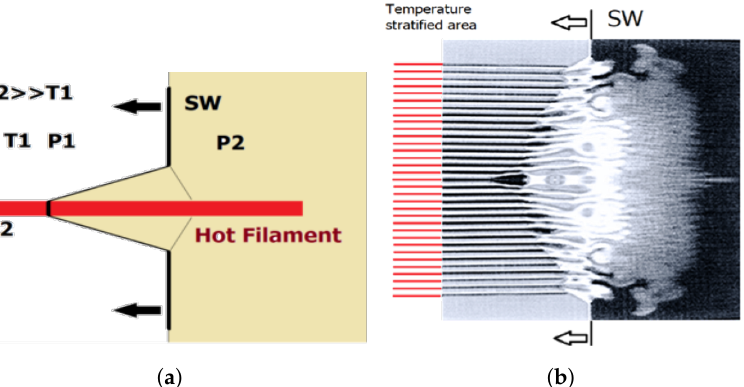
Figure 1. Illustration of the mechanism of SW interaction with thermally nonuniform layer: ( a ) schematics; ( b ) SW interaction with a thermally stratified zone, adapted from